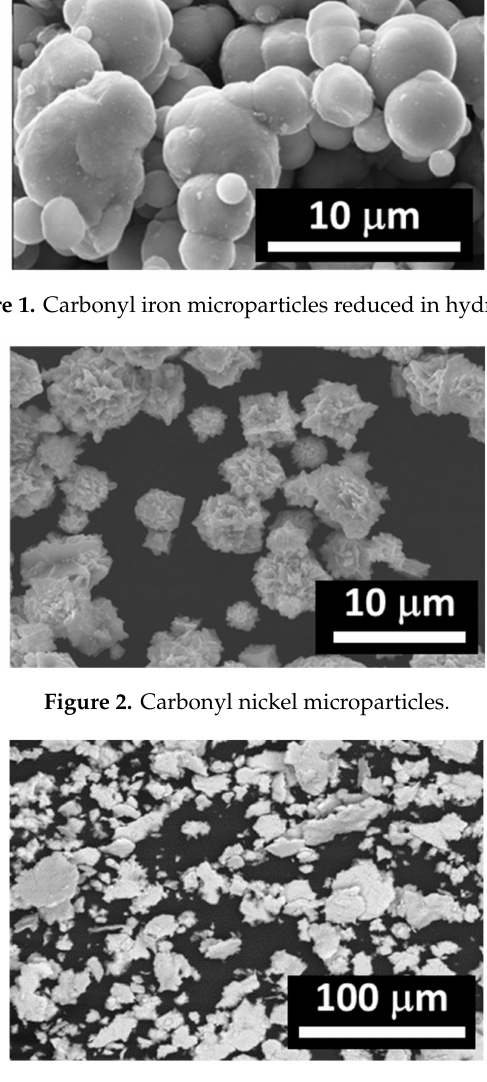
Figure 3. Fe / Ni alloy